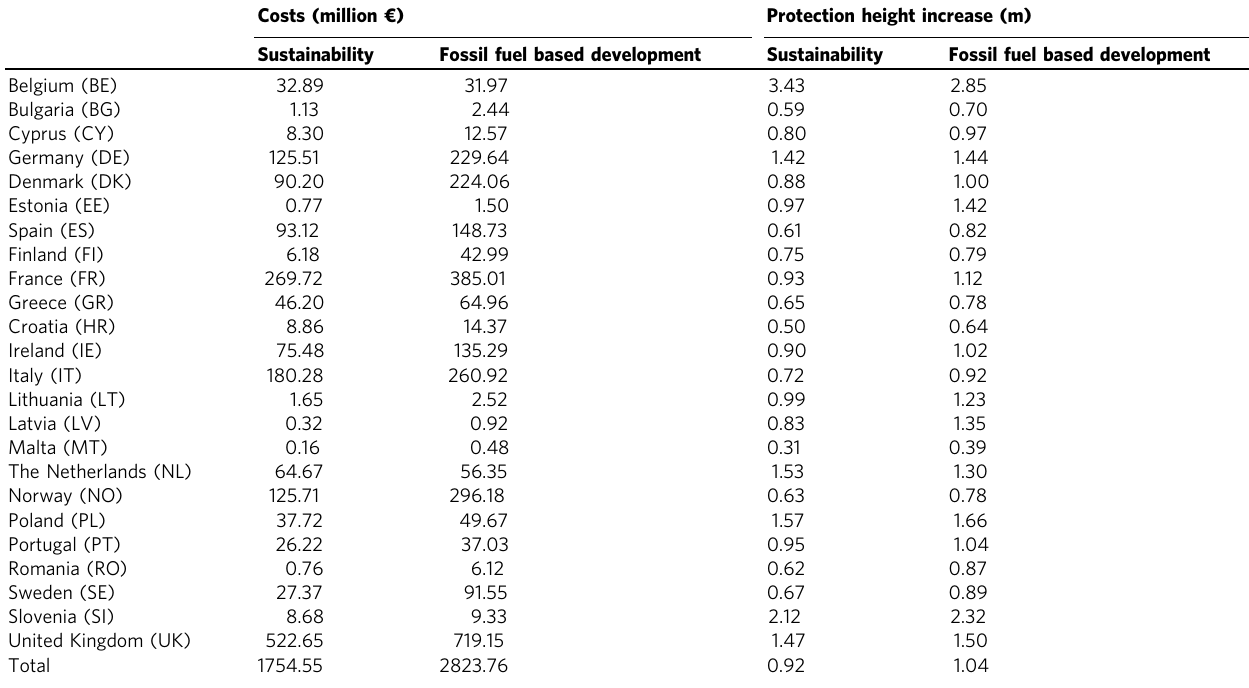
Table 4 Additional protection and related costs. Costs (million € ) Protection height increase (m) Sustainability Fossil fuel based development Sustainability Fossil fuel based development Belgium (BE)